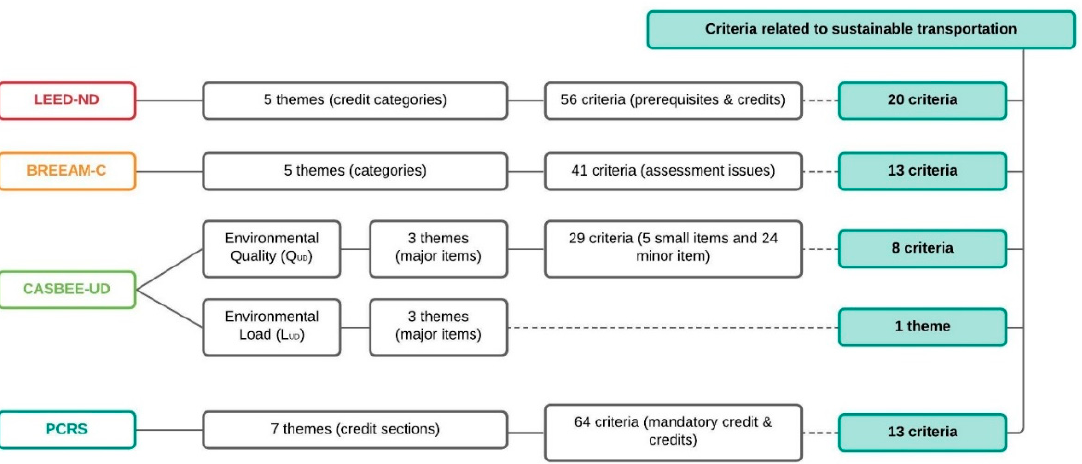
Figure 5. Promotion of active transportation by the four USCs showing the number of criteria required in each of them [78].